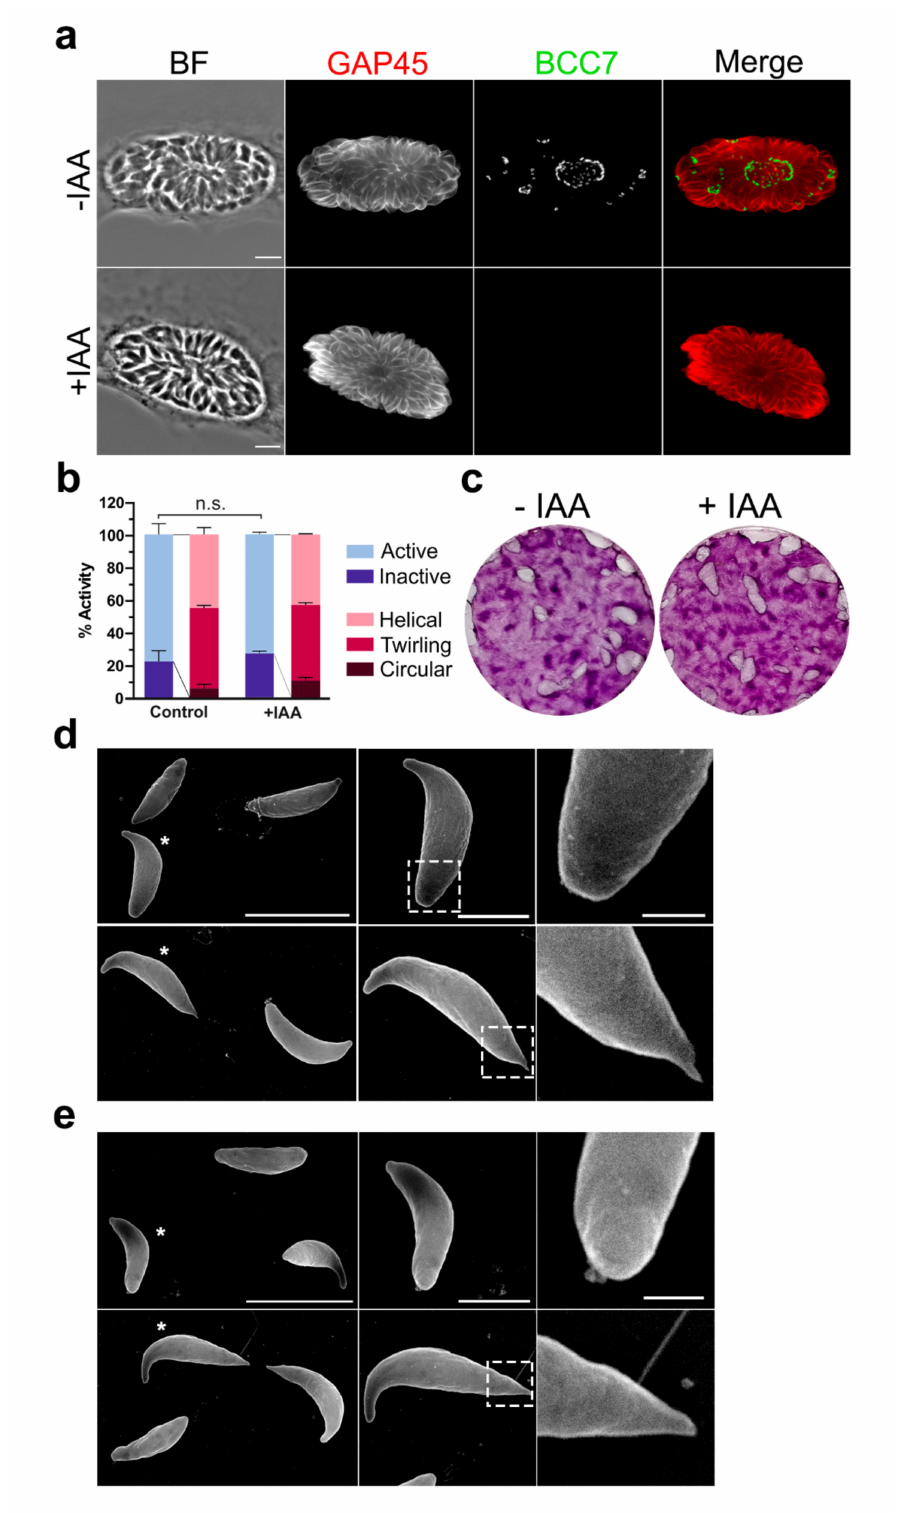
Figure 3. BCC7 is dispensable for the tachyzoite lytic cycle in vitro and does not impact on the ultrastructural organization of the basal pole surface. ( a ) RH_BCC7-mAID-3HA/MyoJ-2TY parasites grown in HFF cells for 48 h ± 500 µ M IAA and fixed just before egress (see Movies S3 and S4). BCC7 depletion was evidenced by HA-immunostaining. No differences in the rate of progeny growing or organization as assessed by GAP45 immunostaining (red), and nuclei DAPI stain in BCC7 wild-type and BCC7-depleted parasites. Scale bar: 5 µ m. ( b ) Graph showing no significant differences in